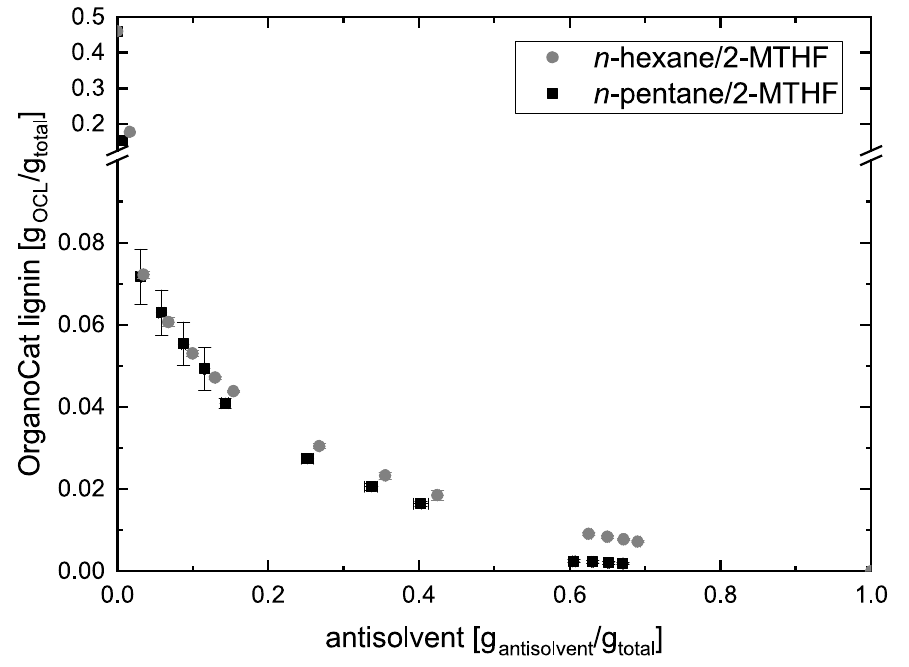
Figure 1. Mass fraction of lignin in equilibrium solution of 2-MTHF as a function of the mass fraction of antisolvent at ambient conditions. Black: OrganoCat lignin (OCL) solubility curve for n -pentane. Gray: OCL solubility curve for n -hexane; two sets of experiments for n -hexane; three sets of experiments for n- pentane.